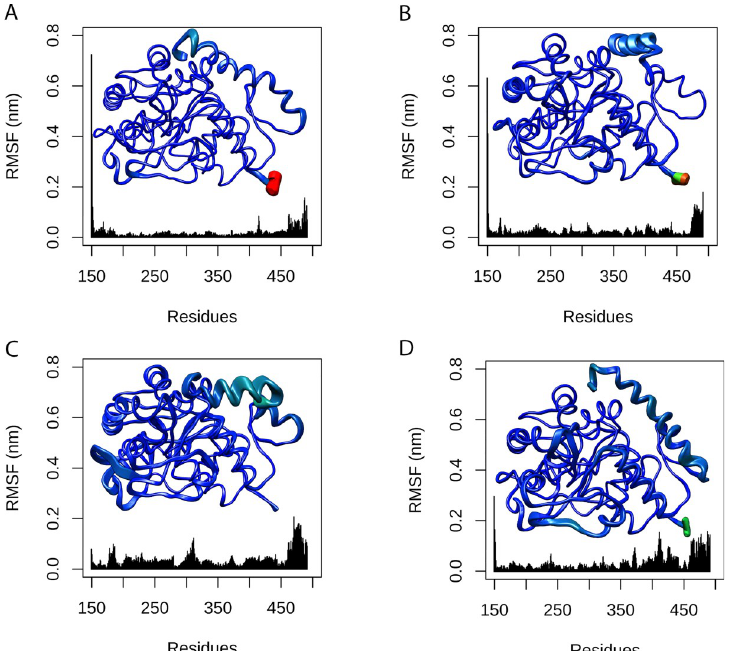
Fig 9. RMSF contribution to PC2 of WT TPH2 and its variants. The RMSF contribution of each protein residue to PC2 is shown as a line plot and projected on the corresponding structure. Each residue of TPH2 WT and variants was colored and sized according to its RMSF contribution. The coloring-thickness scale varies from dark blue and thin (low fluctuations) to red and thick (high fluctuations). (A) RMSF contribution of WT TPH2 to PC2. (B) RMSF contribution of variant P206S to PC2. (C) RMSF contribution of variant R303W to PC2. (D) RMSF contribution of variant R441H to PC2.